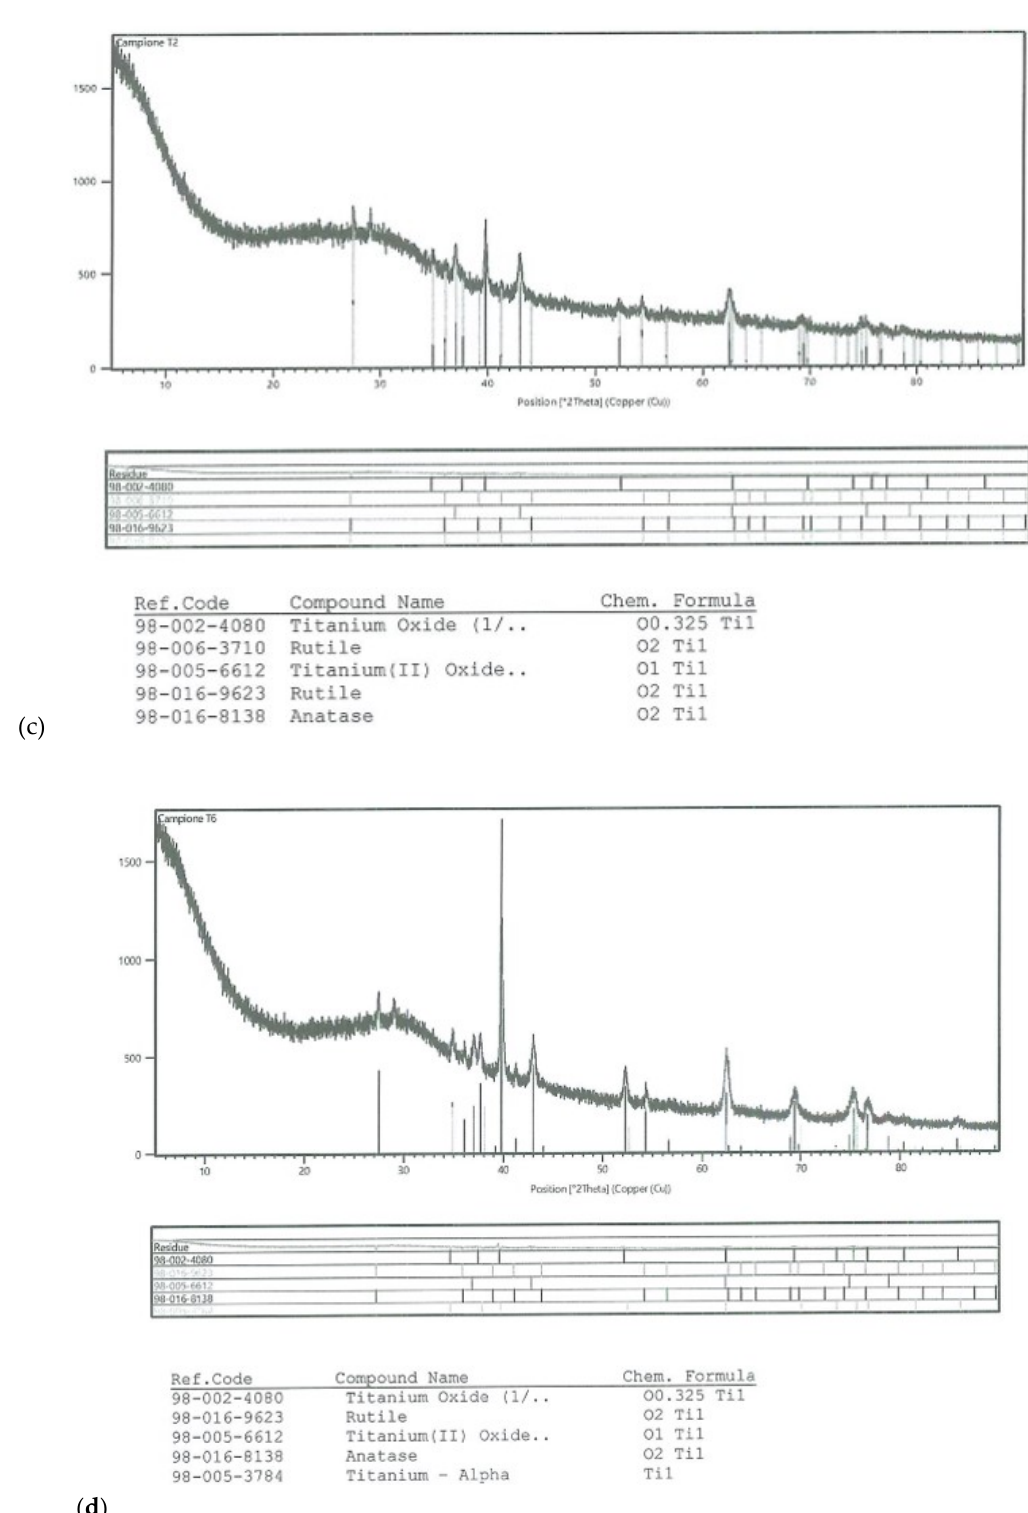
Figure 5. Energy Dispersive X-ray (EDS) analysis of L1, L2, and SBAE ( a ) showed same values of Ti, Al, and V. X-ray power diffraction analysis of SBAE ( b ), L1 ( c ), and L2 ( d ) showed the absence of non-biocompatible compounds.